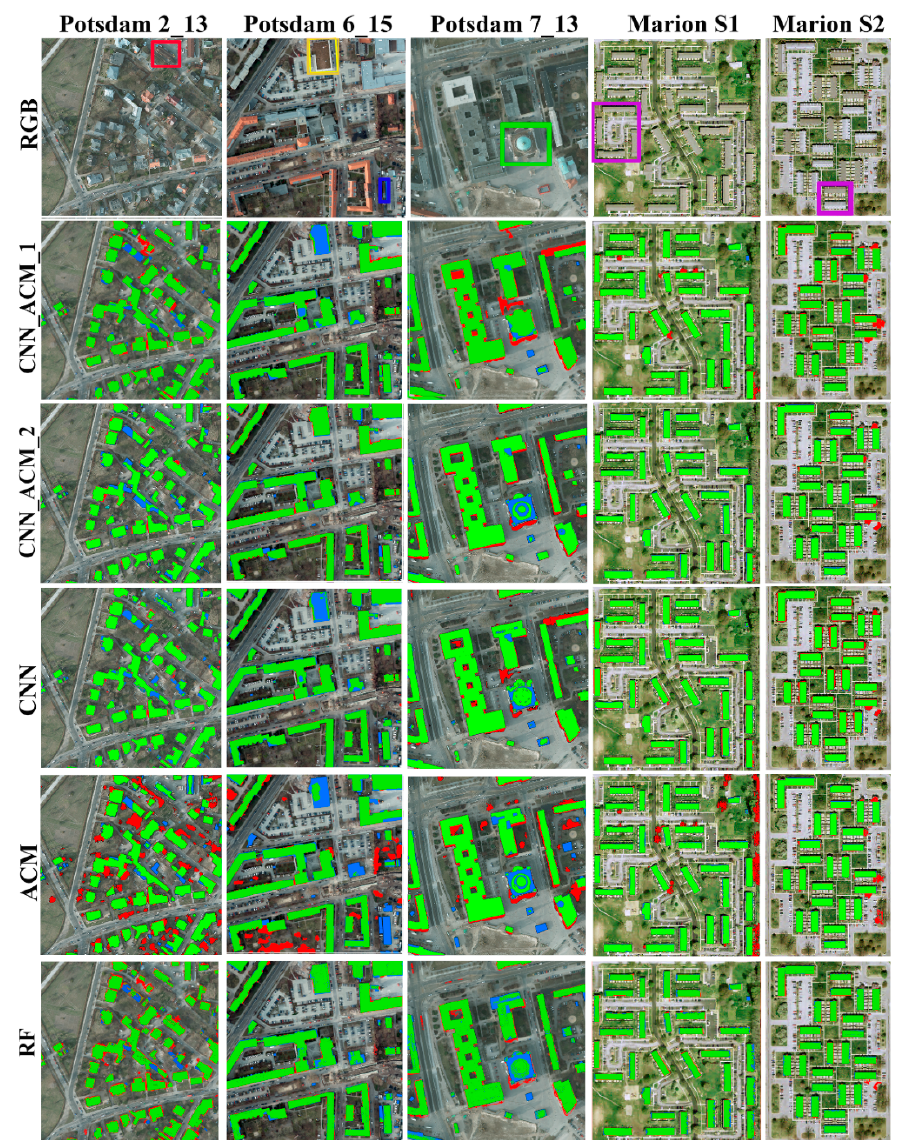
Figure 6. The detected buildings in five test scenes with five different methods. Areas in the green color denote TP , areas in the blue color denote FN , and areas in the red color denote FP at the object level.